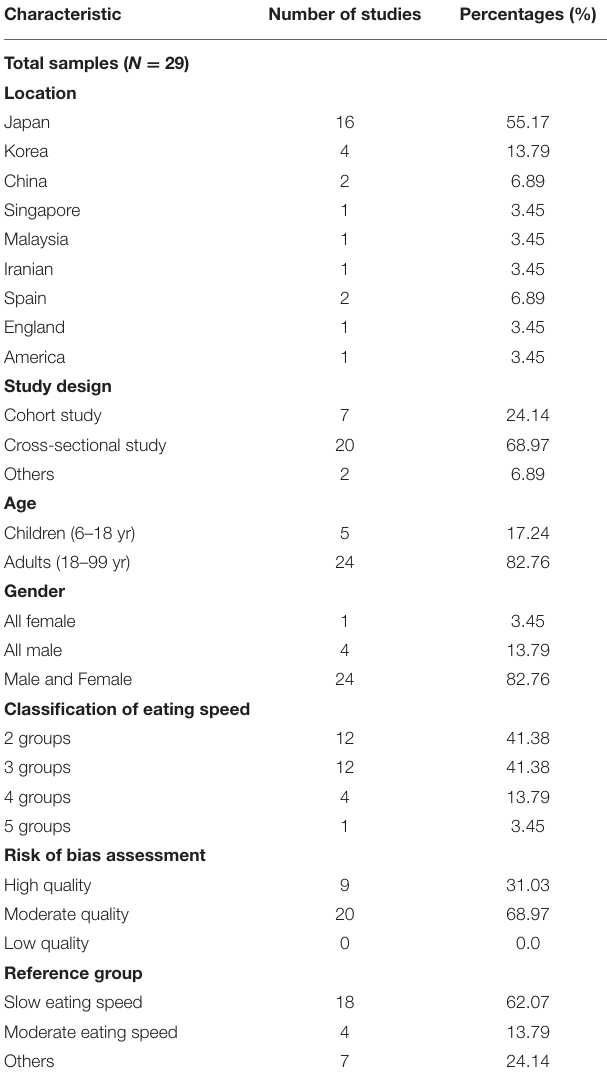
TABLE 1 | The overall characteristics of the studies reporting on the association between eating speed and metabolic syndrome and its components.